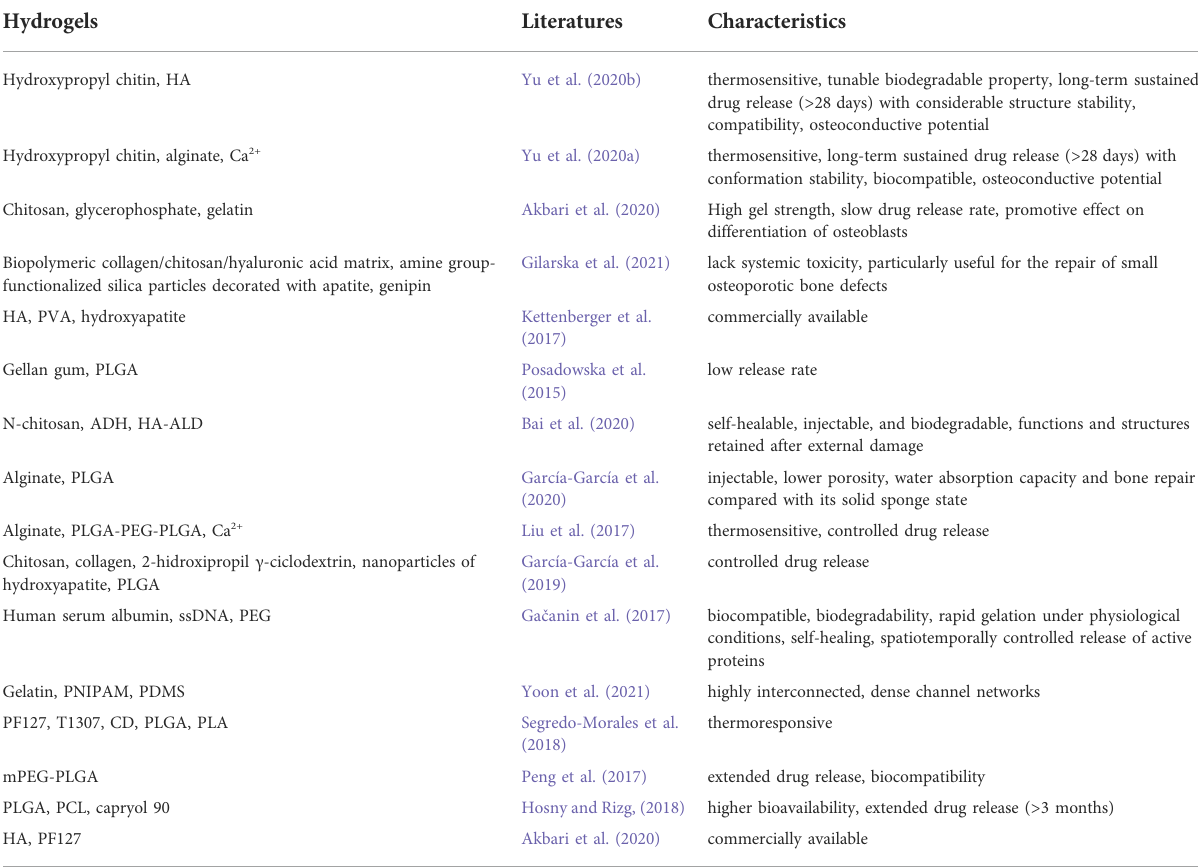
TABLE 3 Components and characteristics of composite